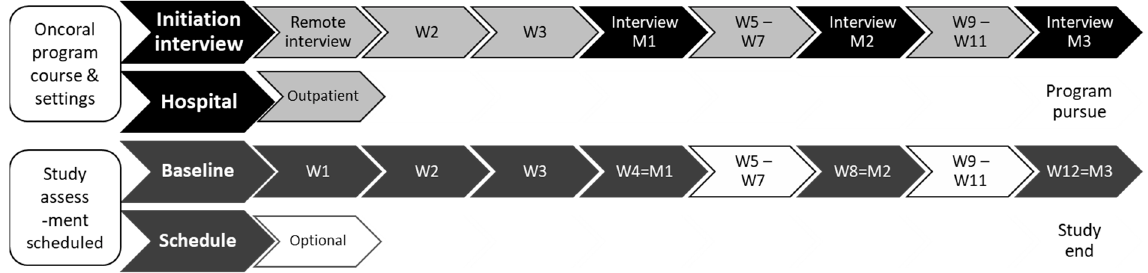
Figure 1. Diagram of patient follow-up in the Oncoral program (all patients) and study assessment schedule (included patients). Caption: W = week; M =